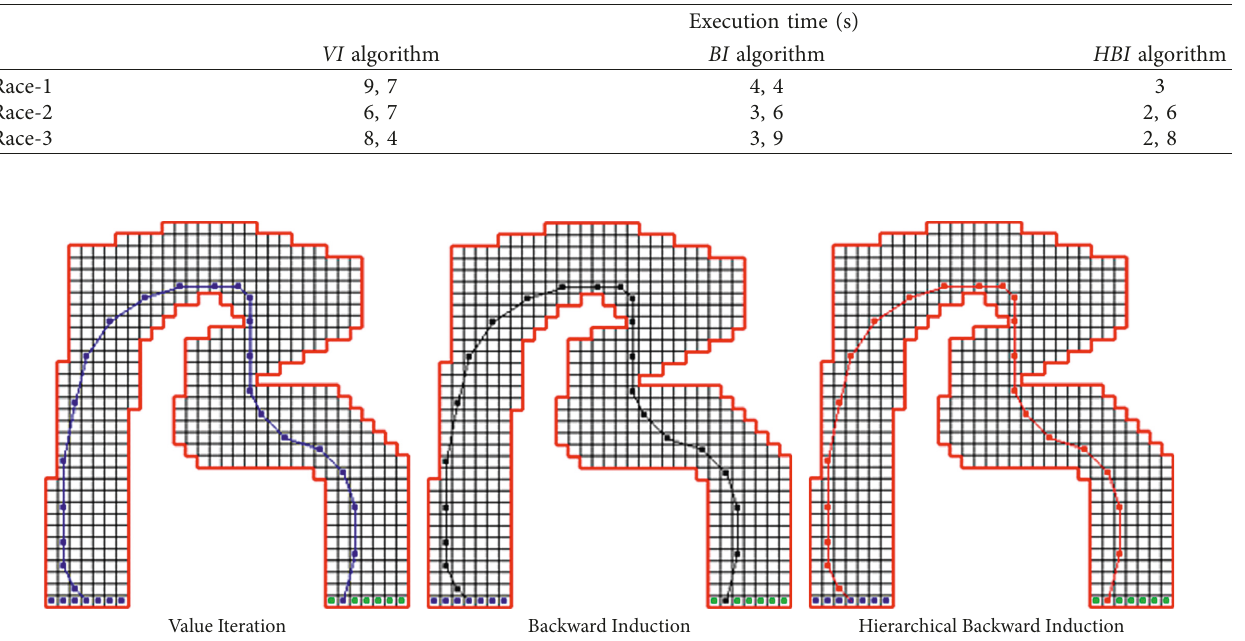
Figure 3: Road generated by VI, BI, and HBI algorithms for the